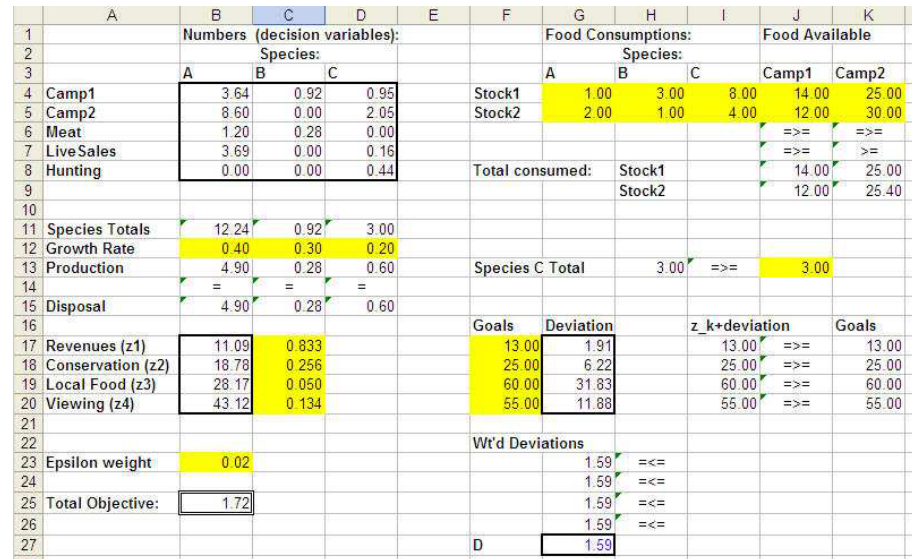
Figure 2: Chebychev goal programming formulation for the game reserve planning LP. ( w ) are specified in C17:C20 . The deviational variables δ i weighted deviations ( w δ ) in G23:G26 . The maximum deviation (∆) is stored in G27 . i i